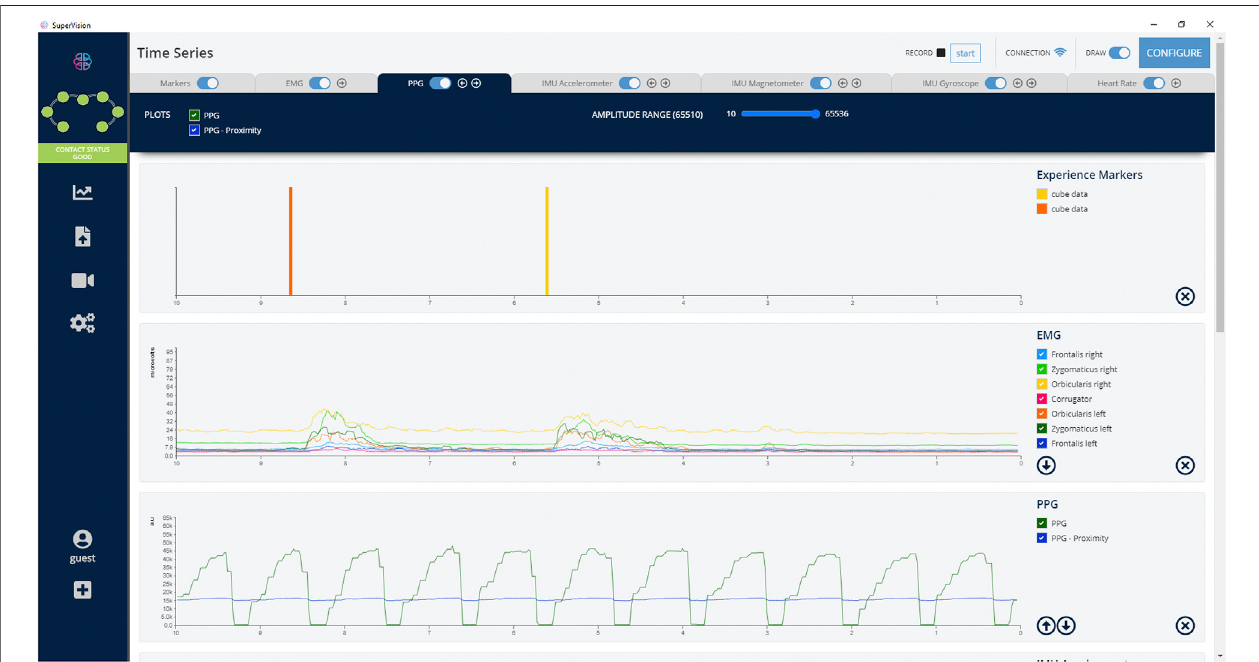
FIGURE 8 | SuperVision main interface. Customisable layout, showing three selected data streams for 2 facial expressions: Experience Markers (custom, user- de fi ned events from the application), overlayed EMG for all seven channels (any combination of channels can be shown/hidden by clicking on appropriate checkboxes) and PPG (proximity and raw signal).